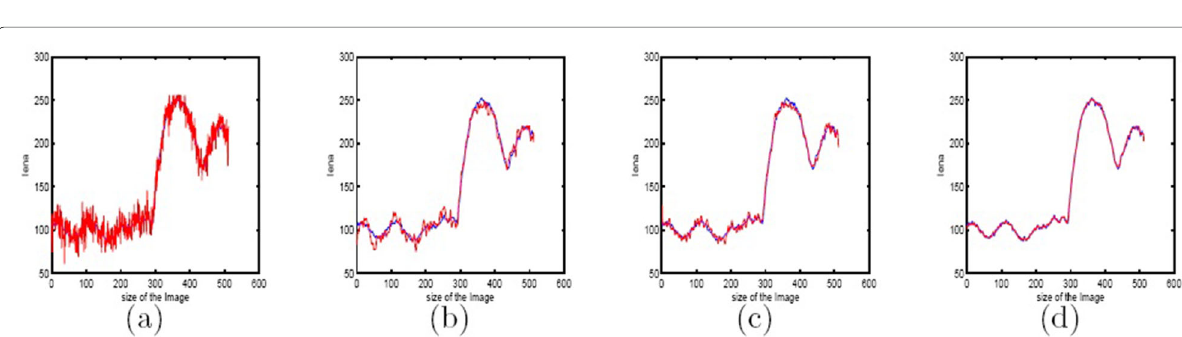
Fig. 11 The 57th line comparison of original image with noisy image, restored image by model M1, restored image by method M2, and restored image by method M3 of the “Lena”. a Original and noisy image lines; b original and restored by method M1 image lines; c original and restored by method M2 image lines; d original and restored by method M3 image lines. The blueline is the original image, and redline is the restored image